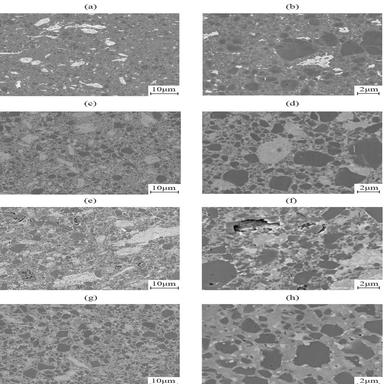
SEM images of TiCXN1-X-TiCrNbMoTa composites (a) X = 0, low margination (b) X = 0, high margination (c) X = 0.5, low margination (d) X = 0.5, high margination (e) X = 0.7, low margination (f) X = 0.7, high margination (g) X = 1.0, low margination (h) X = 1.0, high margination.